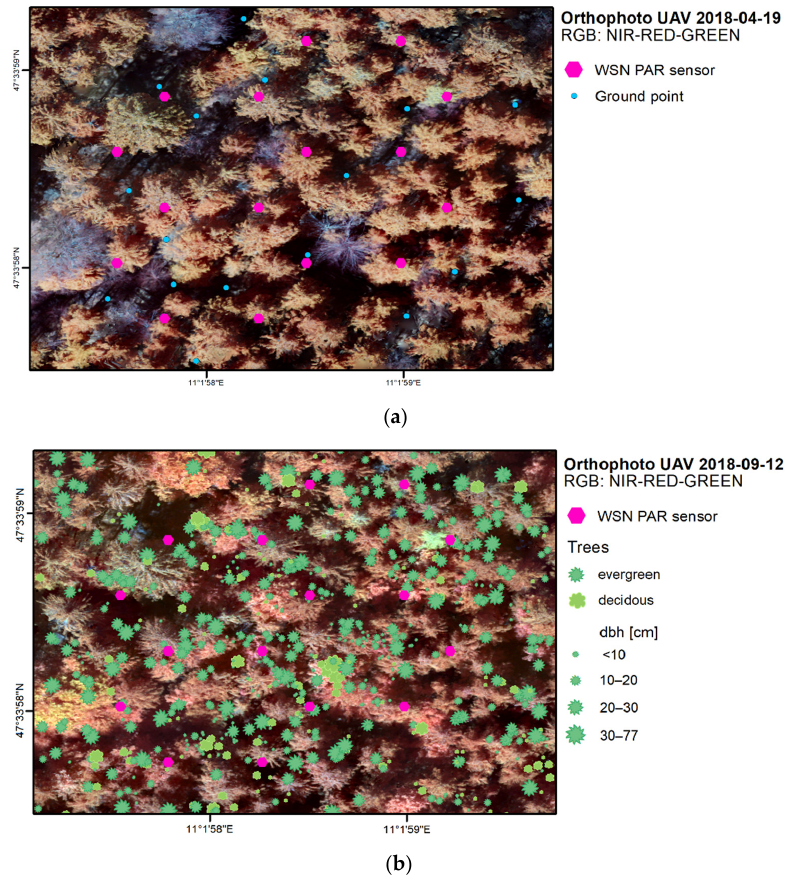
Figure 1. Overview of the area covered by the Wireless Sensor Network of PAR sensors (pink hexagons) for FAPAR measurements. UAV orthophotos are shown in a false color infrared band combination: ( a ) image taken during defoliated deciduous canopy in the spring; the blue point symbols indicate seed points needed for the ground classification routine; ( b ) image taken in the summer with foliated deciduous canopy; green symbols represent the DBH and species composition. Table 1. Species composition in the 10-m surroundings of the 16 sensor locations (for measurements of transmitted PAR). The small letters in the column “location ID” indicate spruce-dominated (co- niferous, “c”) or mixed (coniferous–deciduous, “d”) species compositions. Location ID